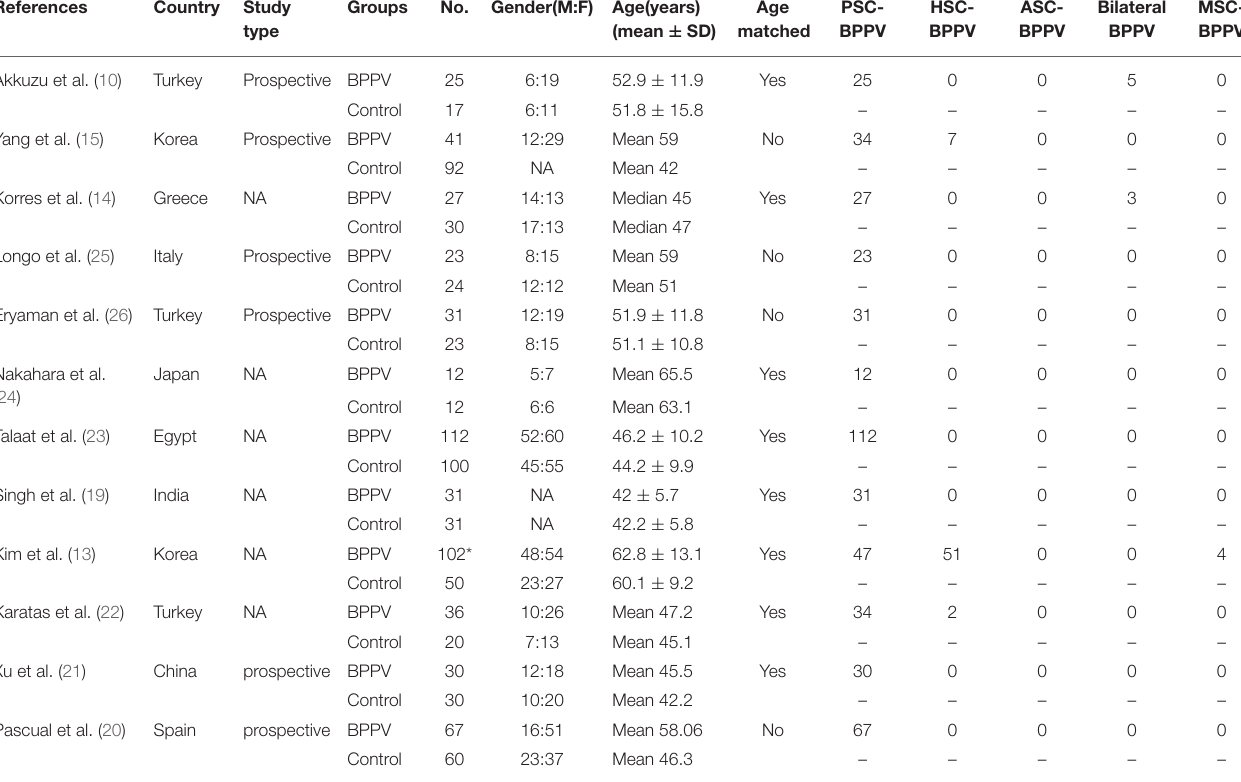
TABLE 1 | The basic characteristics of all eligible